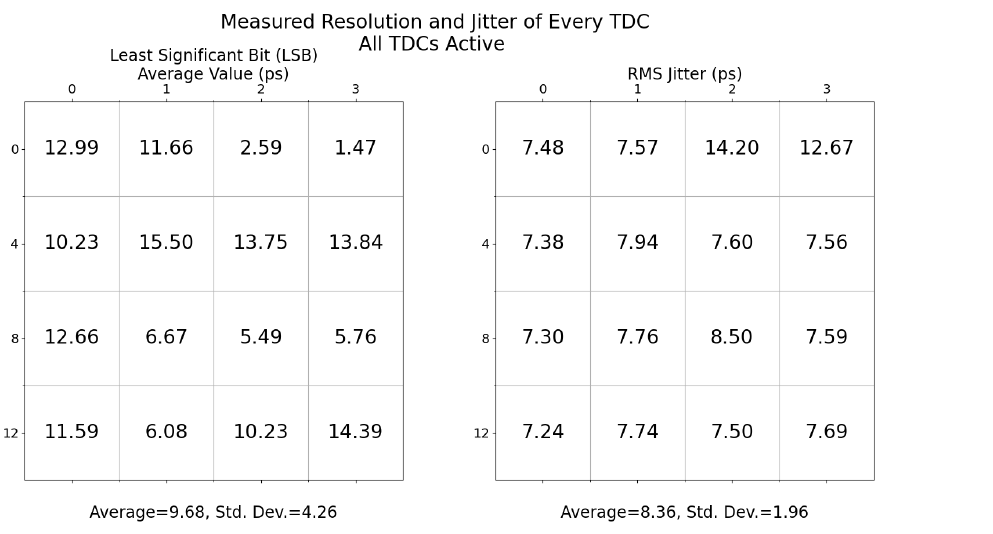
Figure 15. The resolution (LSB) and jitter of each TDC when all are operating at the same time. These results are for head #7 and array #1 of the chip. Due to variations in the fabrication process, not all TDCs have the exact same performance. This can be seen with the outliers, TDCs 2 and 3, having very fine resolutions and, consequently, higher jitter. The TDCs are indexed from the top left (0) to the bottom right (15), with the index of the leftmost indicated for each